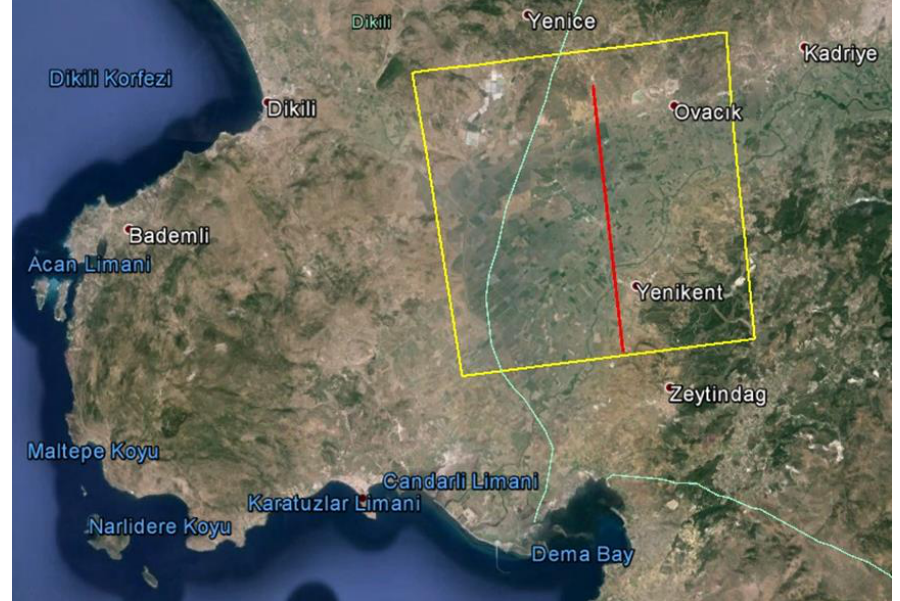
Figure 1. Boundary (yellow frame) of the study area from Google Earth images